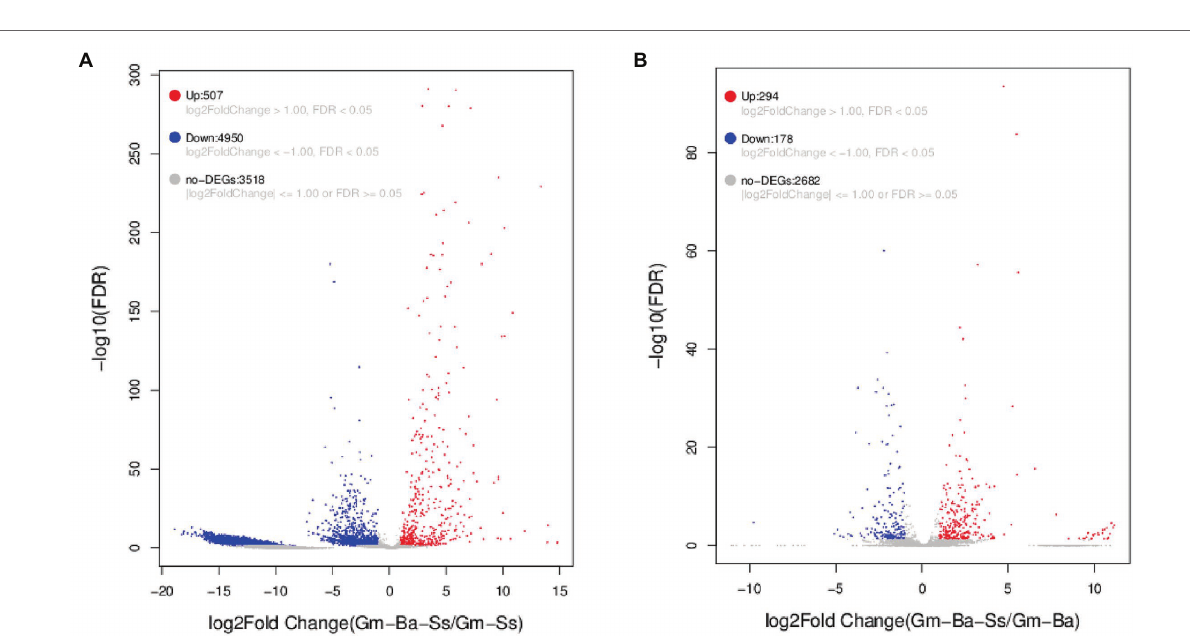
FIGURE 5 | Volcano map of differentially expressed genes (DEGs). (A) S. sclerotiorum DEGs in paired comparison of Gm-Ba-Ss vs. Gm-Ss; (B) B. amyloliquefaciens in paired comparison of DEGs Gm-Ba-Ss vs. Gm-Ba. Gm-Ba, Gm-Ss, Gm-Ba-Ss indicated that the Glycine max seedling were inoculated with B. amyloliquefaciens , S. sclerotiorum and their mixture, respectively. Each dot represents a specific gene. Red dots indicating significantly up-regulated genes and blue dots indicating significantly down-regulated genes. Black dots are not